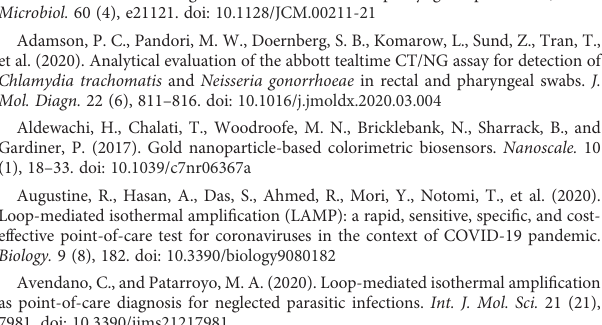
SUPPLEMENTARY FIGURE 1 Nucleotide sequences and location of the C. trachomatis-ompA and N. gonorrhoeae - orf1 genes used to designed the mLAMP primers. SUPPLEMENTARY TABLE 1 Comparison of mLAMP-AuNPs-LFB and qPCR methods for assessment of C. trachomatis and N. gonorrhoeae in clinical